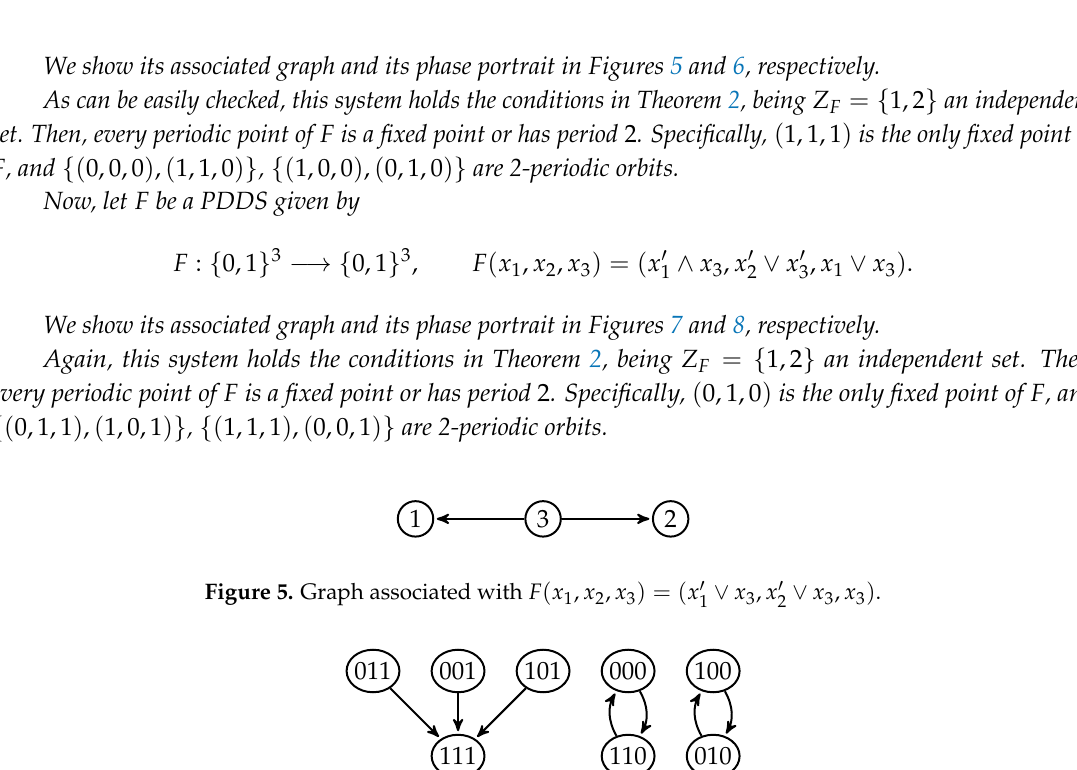
Figure 6. Phase portrait of the system F ( x 1 , x 2 , x 3 ) = ( x (cid:48)